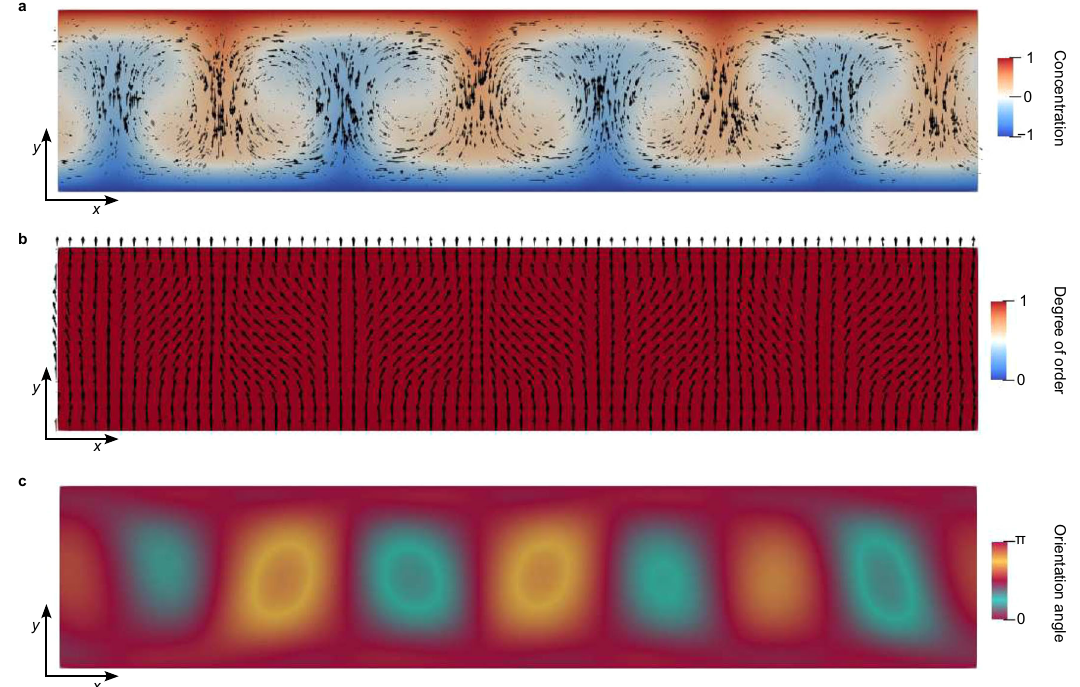
n = ð cos α ,sin α Þ and α ϵ [0, π ] matches the color palette of the red-plate micro- scopy in Fig. 4. Periodic distortions of yellow and blue correspond to the periodic deformation of the orientational fi eld. This fi gure is a snapshot from Supplemen- tary Movie